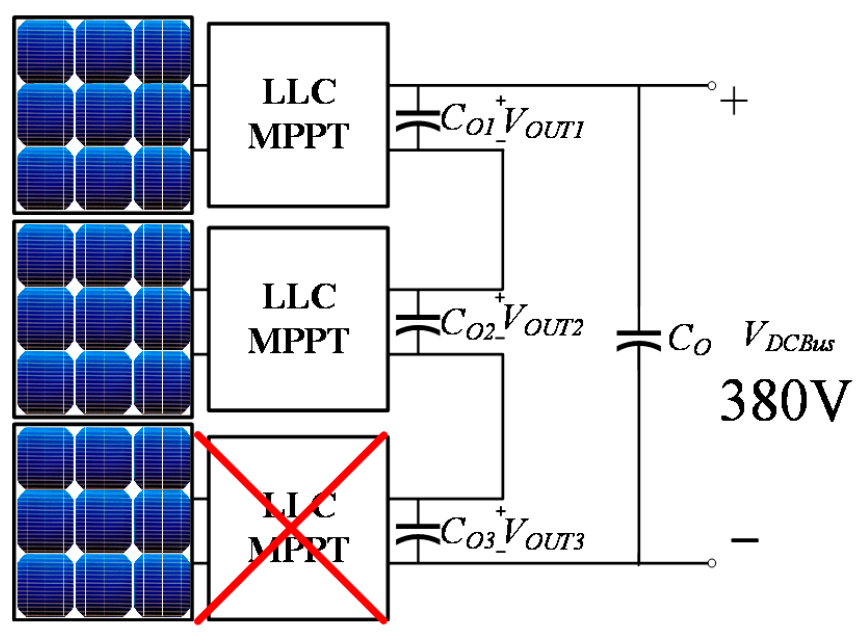
Figure 16. The system is operated in abnormal mode.